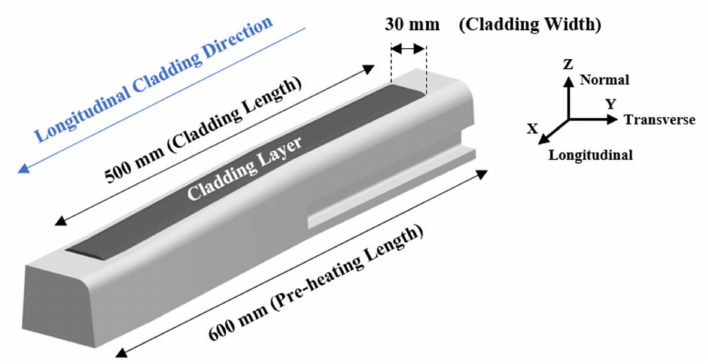
Figure 1. Schematic diagram of the laser cladded light